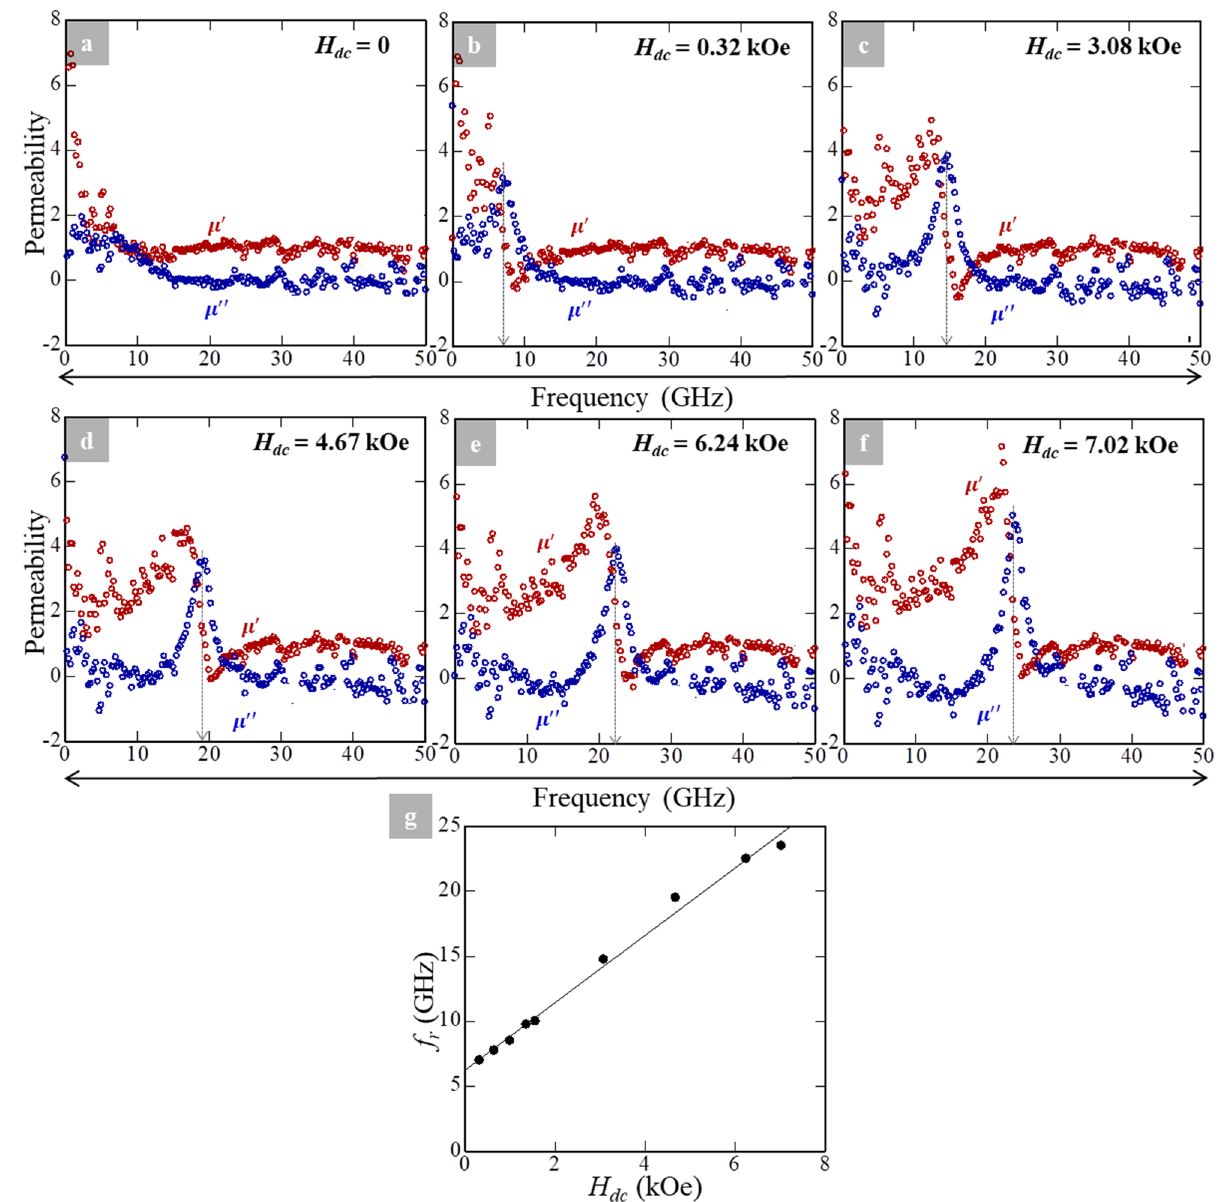
Figure 4. Frequency dependence of dynamic permeability obtained by the MSL-probe method up to 50 GHz. The external magnetic DC field ( H dc ) applied during the measurements is ( a ) 0, ( b ) 0.32, ( c ) 3.08, ( d ) 4.67, ( e ) 6.24, and ( f ) 7.02 kOe, respectively. ( g ) The relationship between f r and H dc based on the results form measurements with a linear